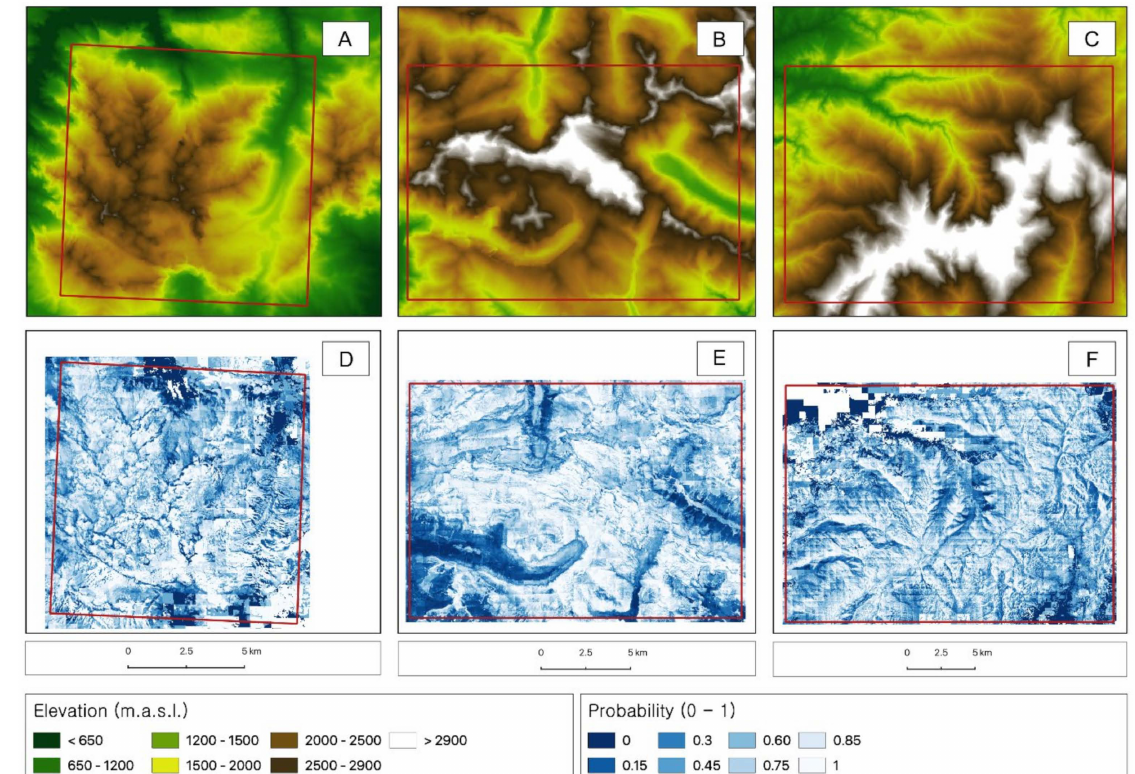
Figure 3. The ( A – C ) panels respectively show the Digital Elevation Models (DEM) of Picos de Europa, the Pyrenees and Sierra Nevada (DEMs from the Instituto Geogr á fico Nacional (Spanish National Geographic Institute)). The ( D – F ) panels depict the spatial distribution of the ProbMODIS probabilities for Picos de Europa, the Pyrenees and Sierra Nevada, respectively. The probabilities of this example were obtained for the entire study period with Sentinel-2 images